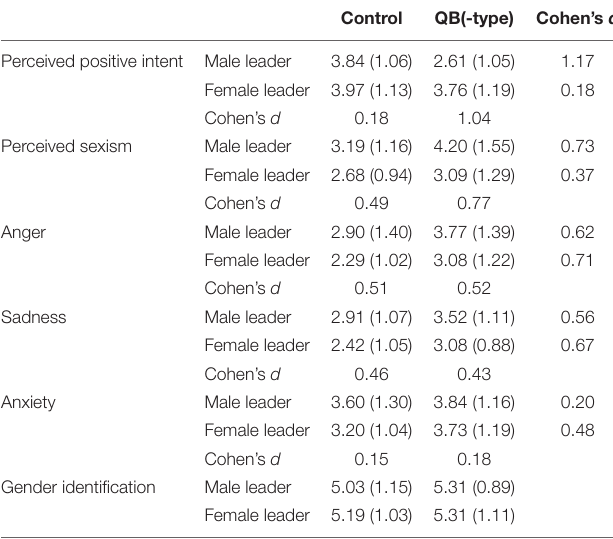
TABLE 2 | Descriptive statistics by leader gender and leader